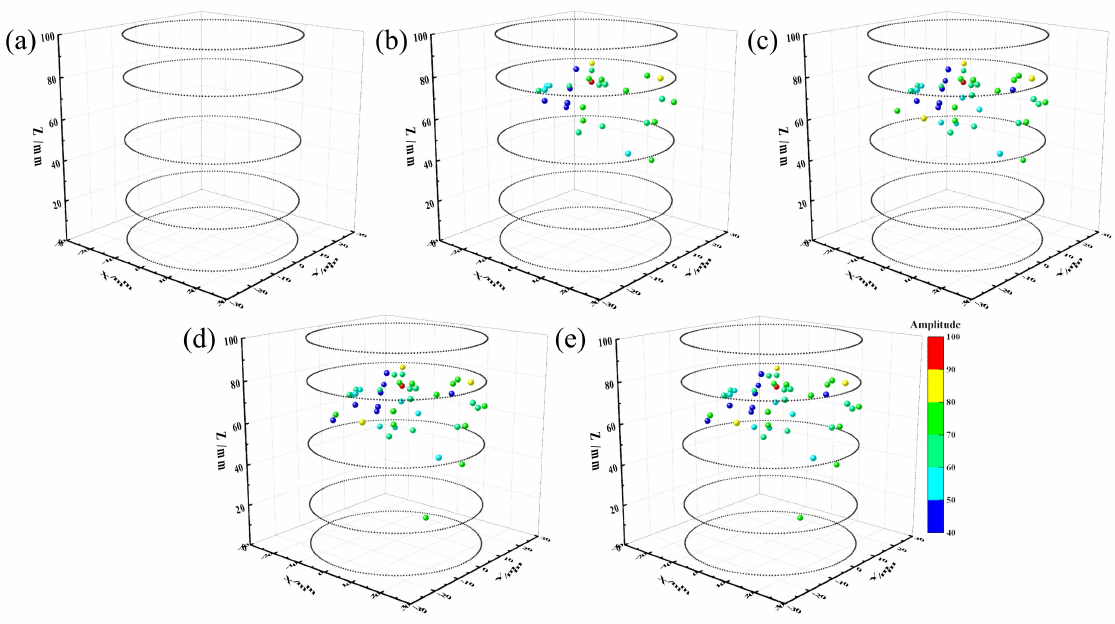
Figure 8. Spatial evolution of AE events of coal samples under different loading rates (0.2 mm/min): ( a ) crack compaction phase, ( b ) crack initiation phase, ( c ) stable crack growth phase, ( d ) unstable crack growth phase, and ( e ) post-peak failure